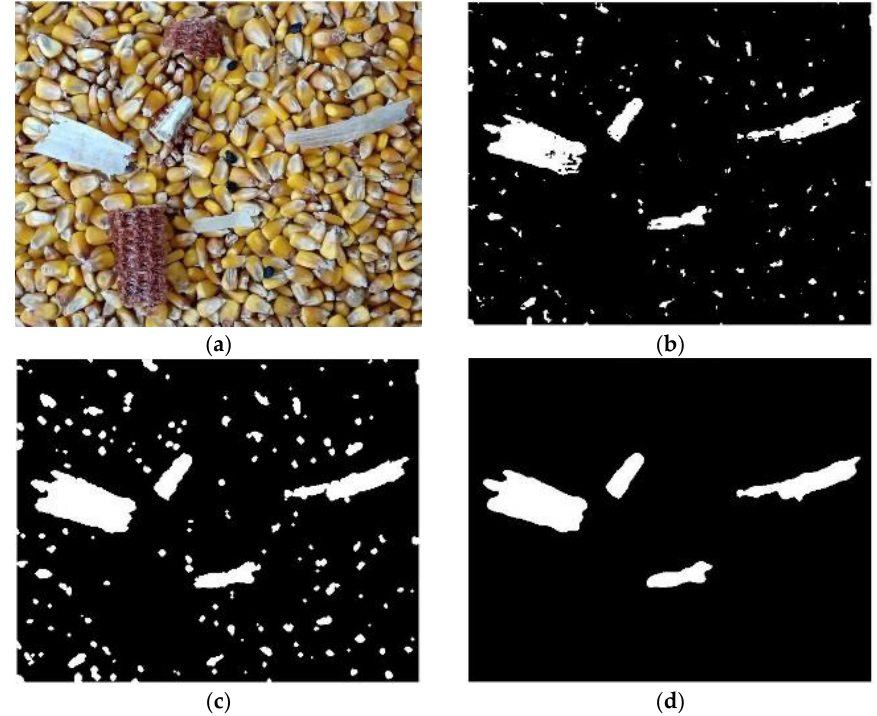
Figure 7. Identification of broken bracts. ( a ) Original image 2 of corn, ( b ) Coarse extraction of broken bracts impurities, ( c ) Filling the hole, ( d ) Broken bracts impurities.